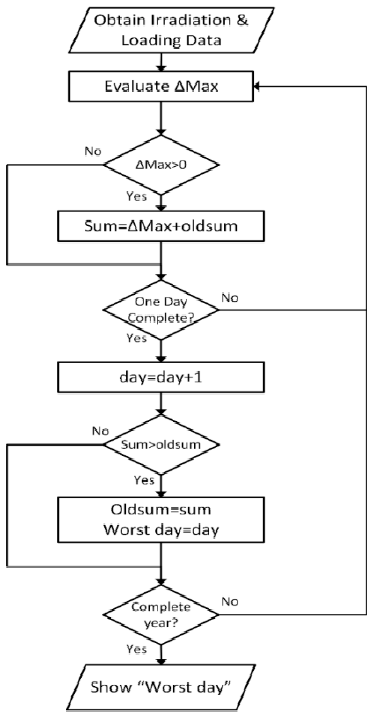
Figure 8. Flowchart for worst day estimation.